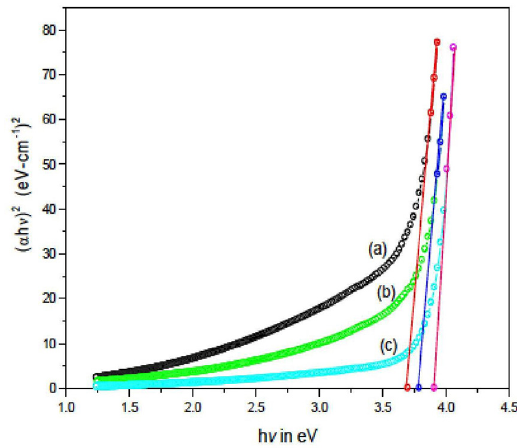
Figure 7: Plot of ( αhv ) 2 versus hv for (a) ZnS , (b) 2.5% Sn : ZnS and (c) 5% Sn : ZnS .